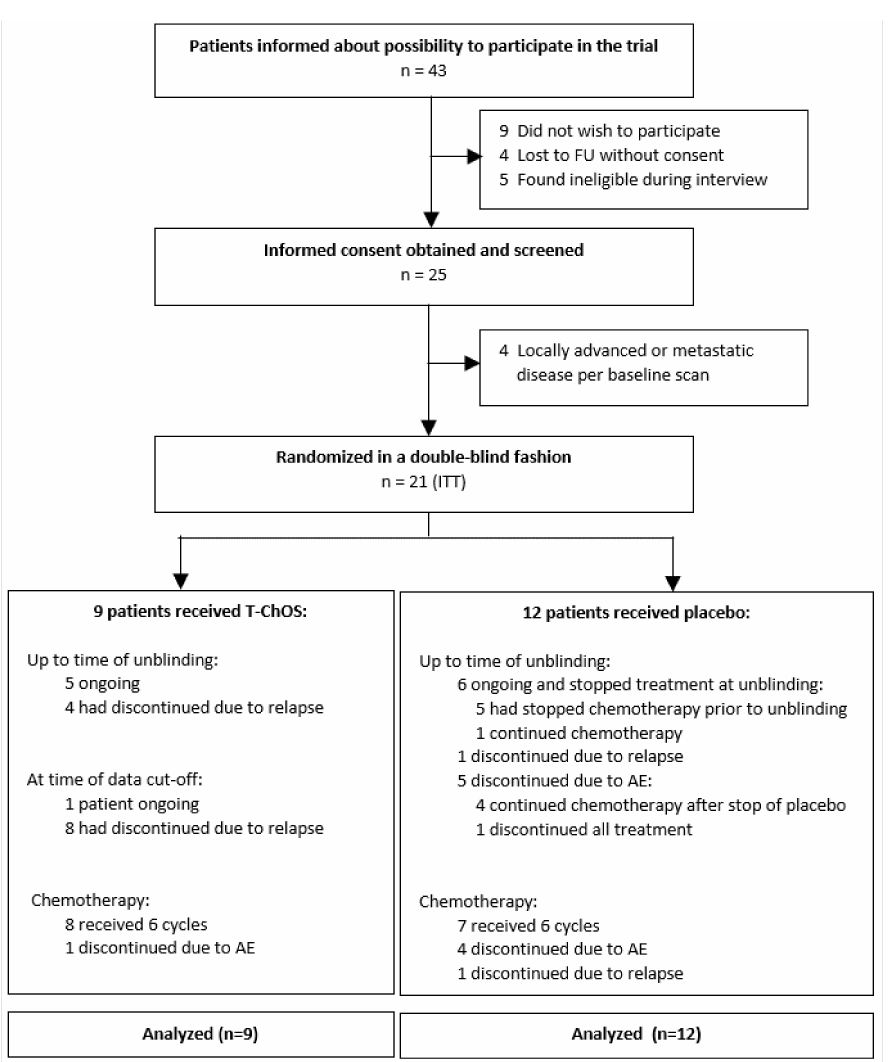
Figure 1. Study CONSORT flow diagram. AE, adverse event; FU, follow-up; ITT,